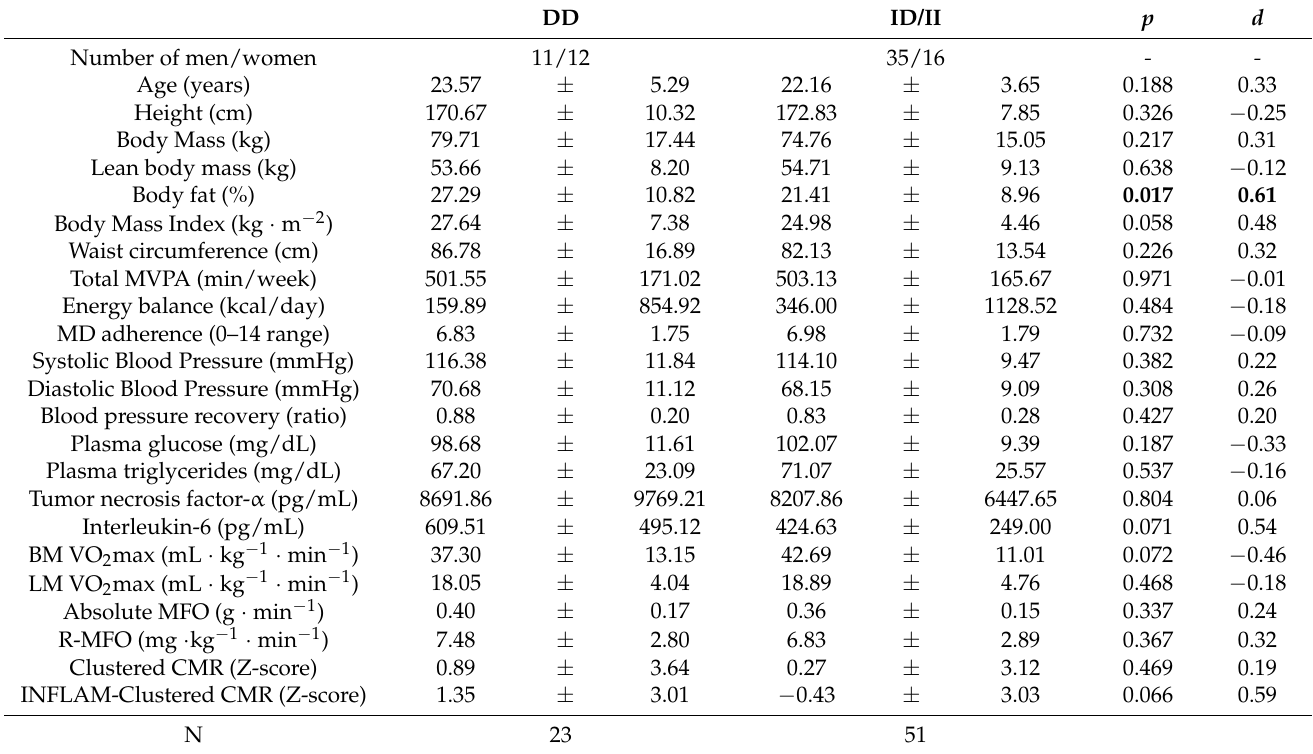
Table 3. Comparisons of the recesive model (DD vs. ID/II) in the analysed outcomes.